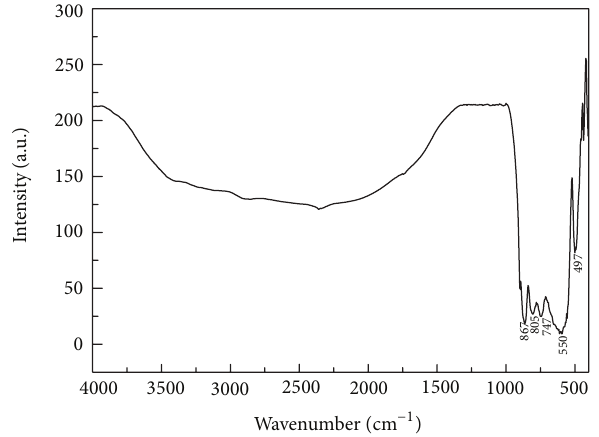
Figure 3: FT-IR spectrum of the as-prepared CaNb 2 O 6 nanopow-